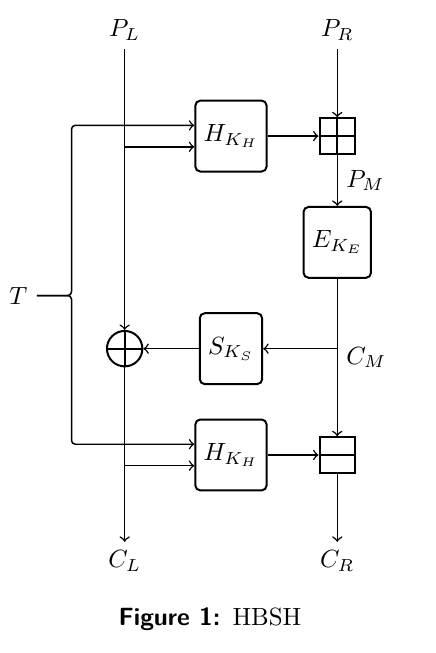
Figure 1: HBSH Figure 2: Pseudocode for HBSH; P R , P M